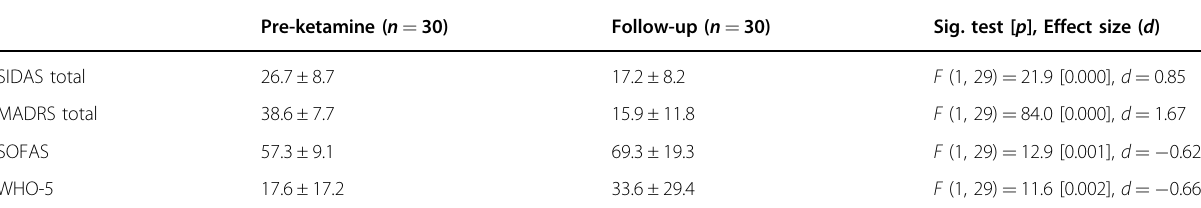
Table 2 Mean scores (±standard deviation) for secondary outcome measures across pre-ketamine and follow-up